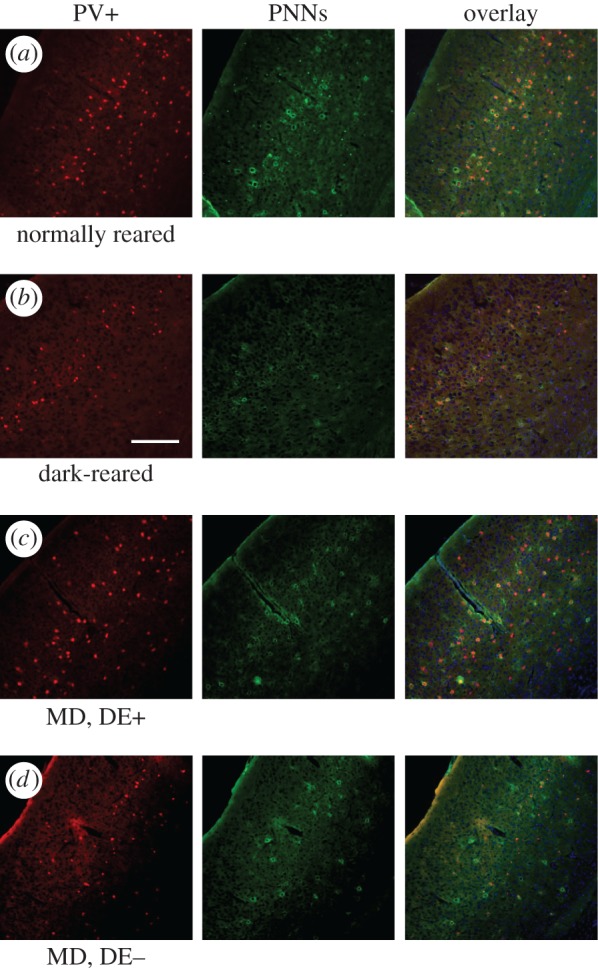
Fluorescence photomicrographs of coronal V1 sections from four mice reared with different visual experiences. (a) Normally reared mouse aged eight weeks. (b) Dark-reared mouse aged eight weeks. (c) Mouse with 30 d MD followed by one week of dark exposure and subsequent binocular recovery. (d) Mouse with 30 d MD followed immediately by four weeks of binocular recovery. Scale bar, 200 µm.